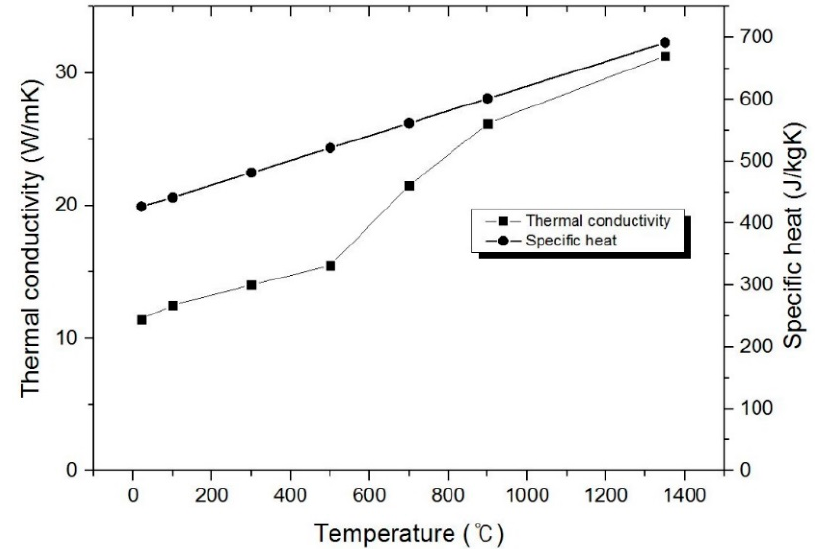
Figure 7. Thermal conductivity and specific heat of Inconel 718 according to temperature. Table 1 . Johnson–Cook constitutive model parameters of the Inconel 718.